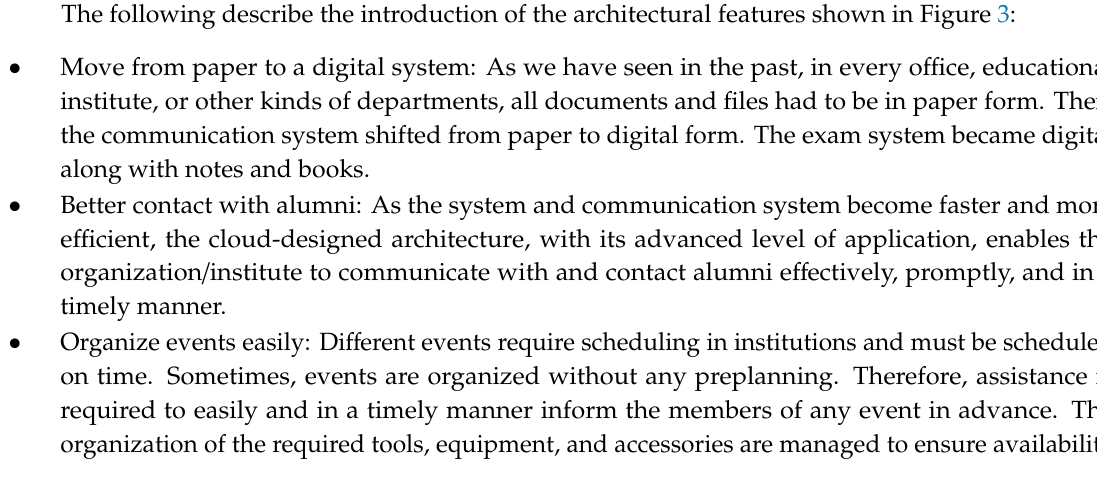
Table 2. Dual activities.